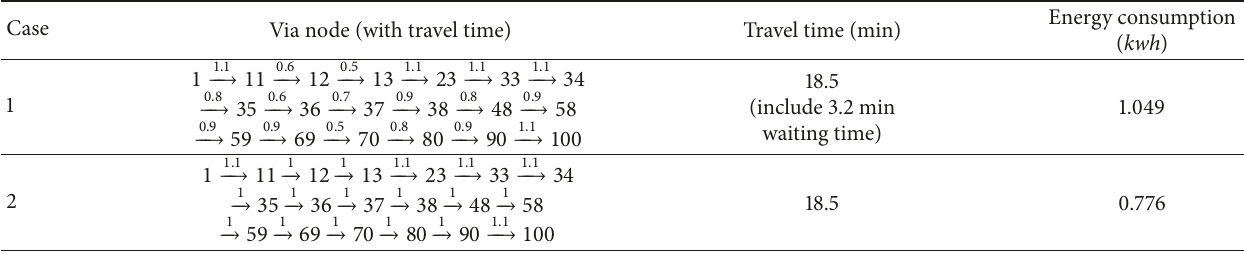
Table 10: The energy consumption in stop driving (Case 1) and nonstop driving (Case 2).